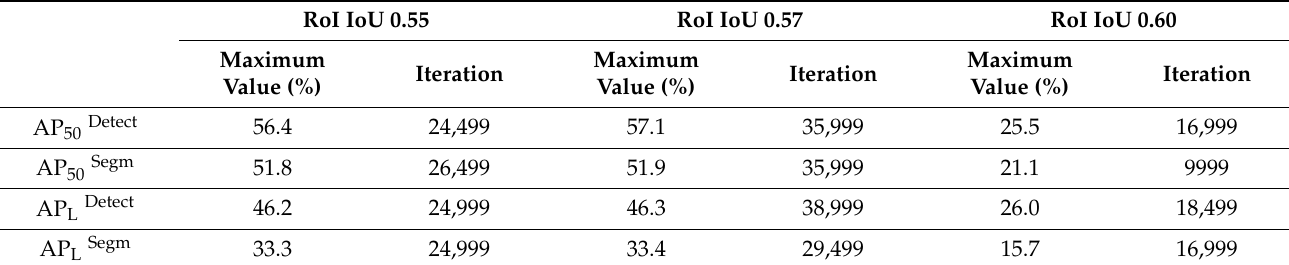
Table 6. Metrics values for models RoI IoU 0.55, 0.57, and 0.60. RoI IoU 0.55 RoI IoU 0.57 RoI IoU